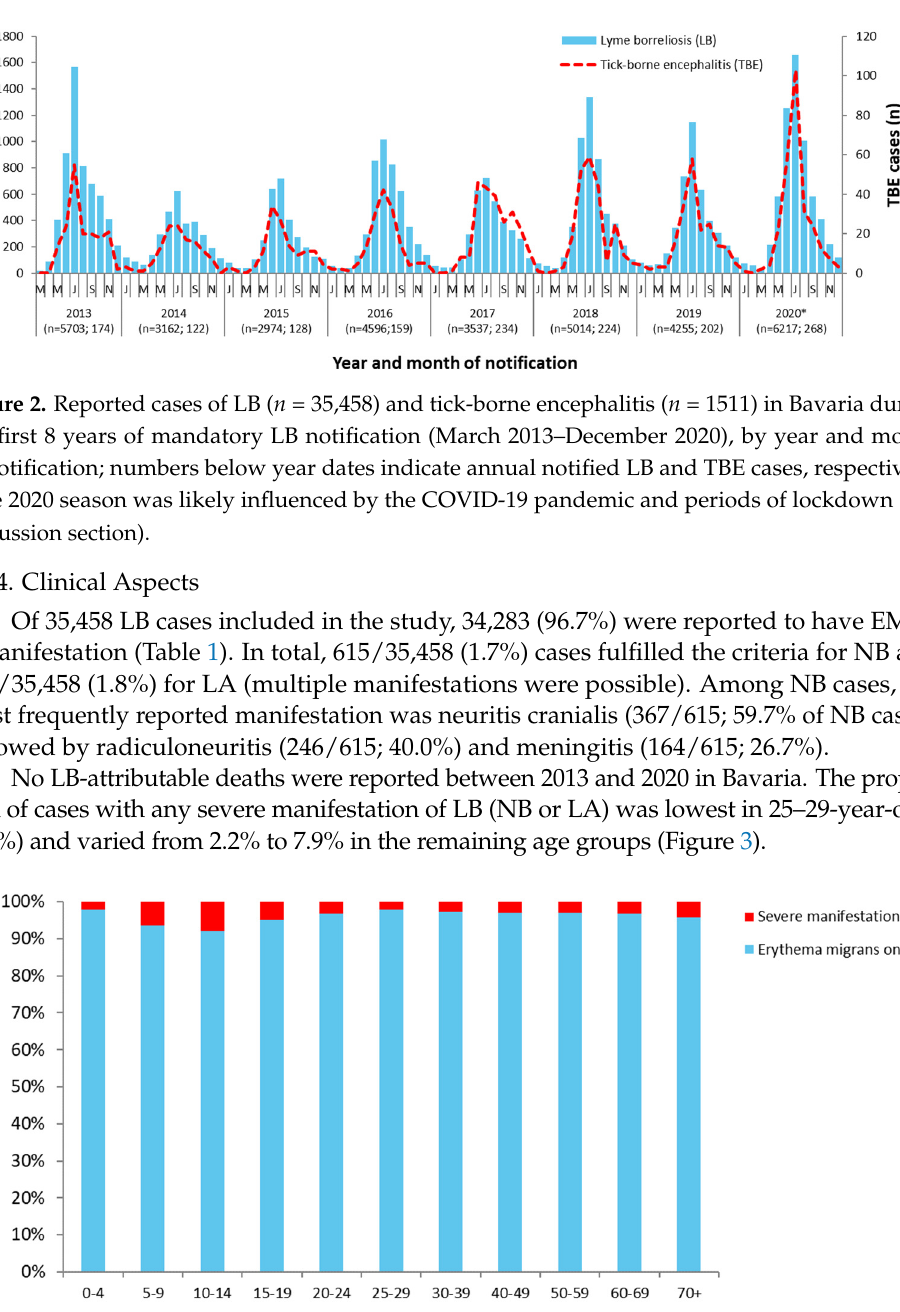
Table 2. Association of age and sex with clinical manifestations among LB cases ( n = 35,458) reported from 2013 to 2020 in Bavaria, Germany: Results of univariate logistic regression analysis.